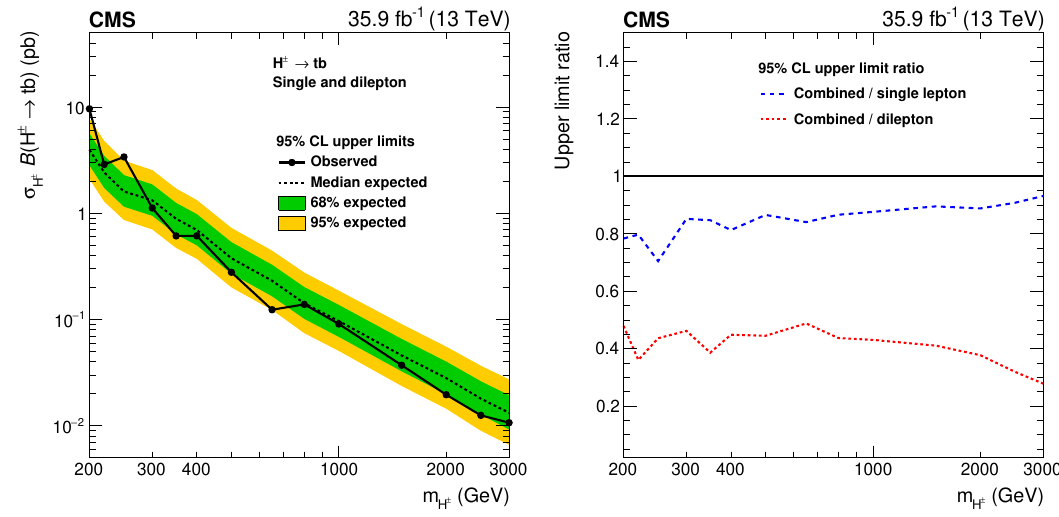
Figure 5 . The upper limit at 95% CL on (cid:27) (H (cid:6) tb) with single-lepton and dilepton (cid:12)nal H (cid:6) B ! states combined (left). The solid black markers describe the observed upper limits, while the dashed line corresponds to the expectations from the background. The green (yellow) band represents one (two) standard deviations from the expected median. The contribution of the single-lepton and dilepton regions to the combined limit is also represented, expressed as a ratio